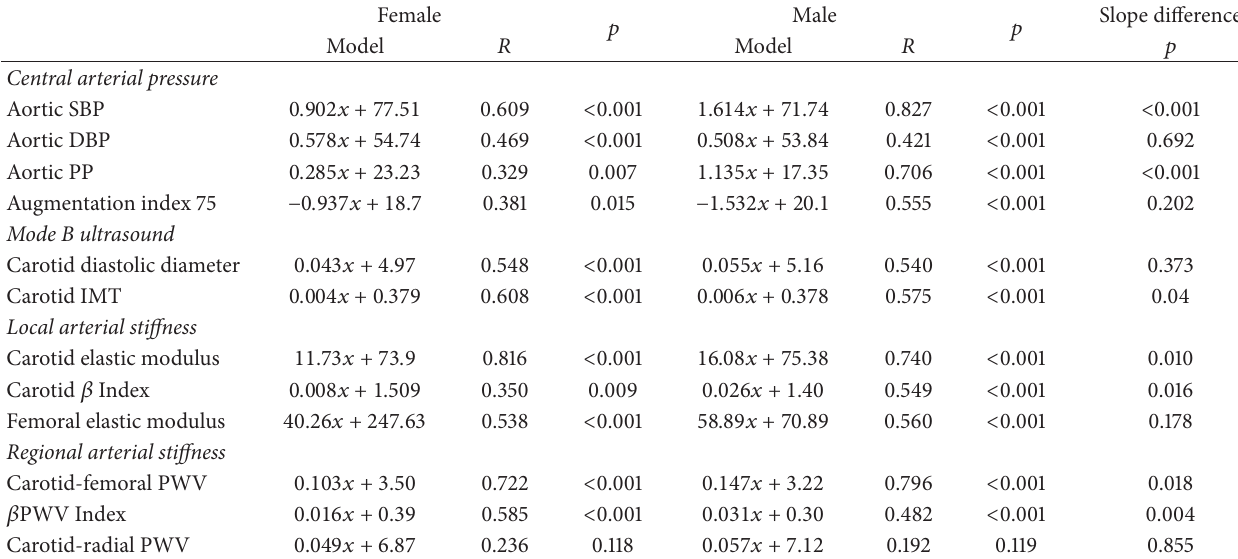
Table 2: Age-related changes. Simple linear regression models.